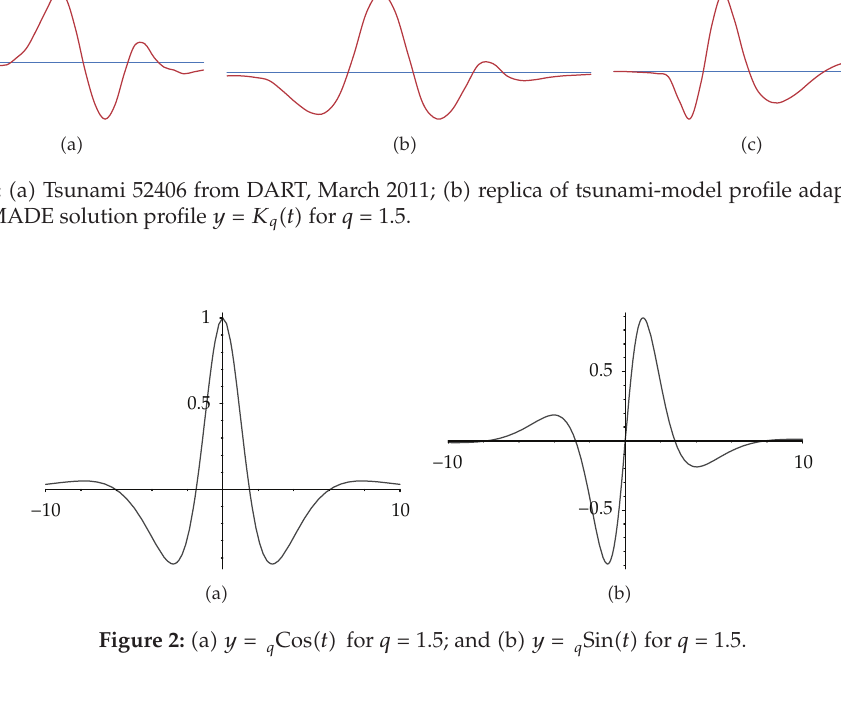
Cos (cid:2) t (cid:3) for q (cid:5) 1 . 5; and (cid:2) b (cid:3) y (cid:5) q